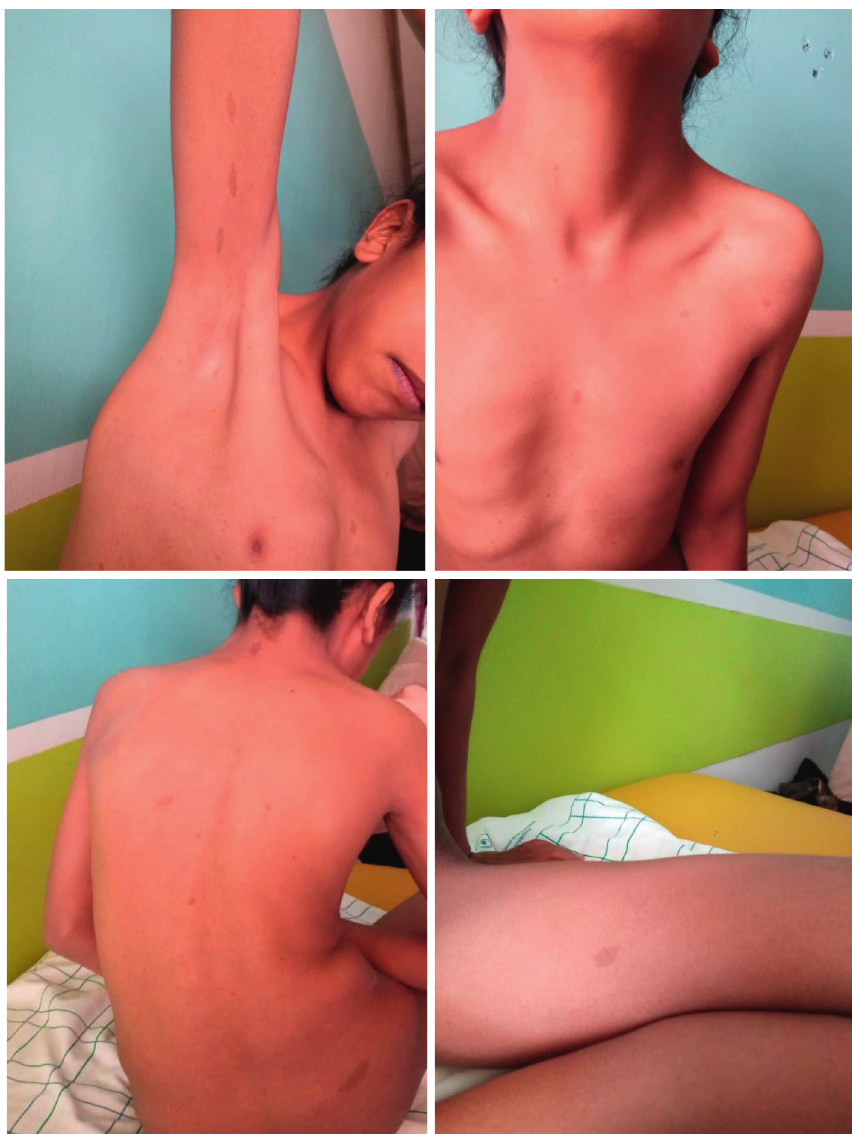
Figure 3: Hyperpigmented skin macules with multiple caf´e-au-lait spots and axillary freckling in our